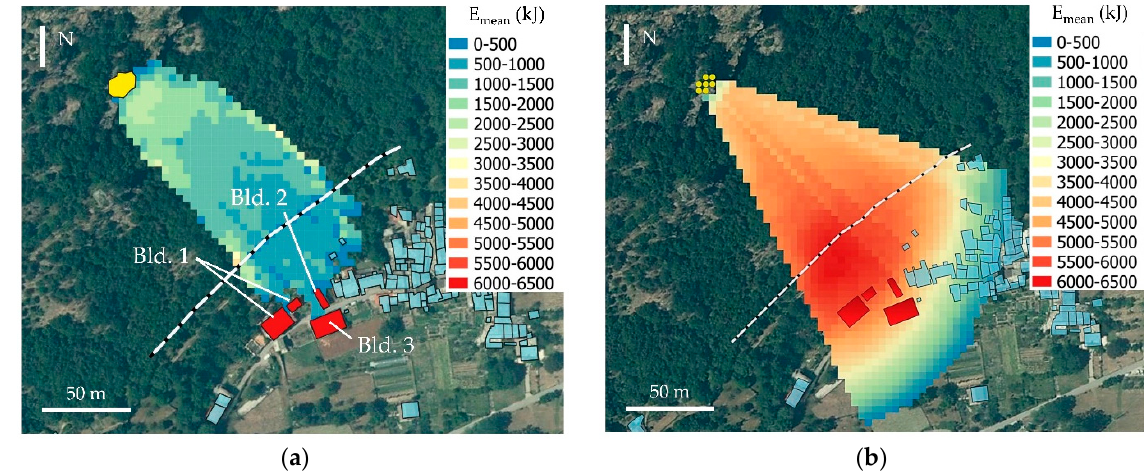
Figure 14. Results of the back analyses for the 2011 rockfall event in Cels-Morlière hamlet (rockfall sources in yellow, barrier in dashed white line, impacted buildings in red). ( a ) Rockyfor3D mean kinetic energy; ( b ) QPROTO mean kinetic energy.